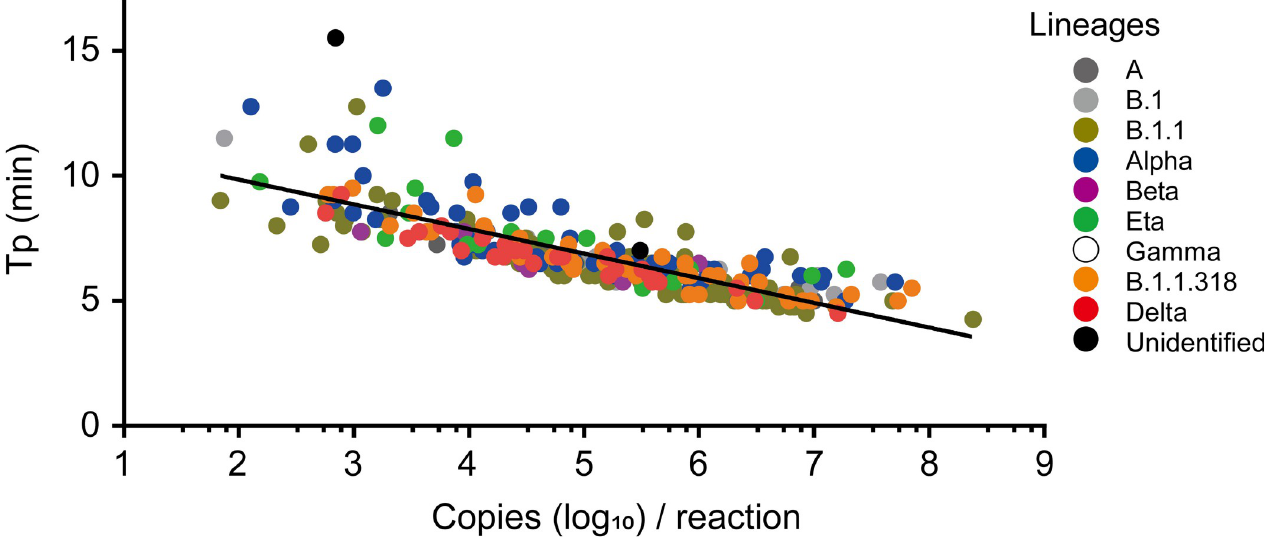
Fig 2. Validation of RT-LAMP assay using clinical samples collected between March 2020 and October 2021 in Gabon. The time to positivity (Tp) determined by RT-LAMP was plotted against viral genome copies per reaction for each sample assessed in this study. Colors depict the lineages of SARS-CoV- 2. The correlation curve is shown on the